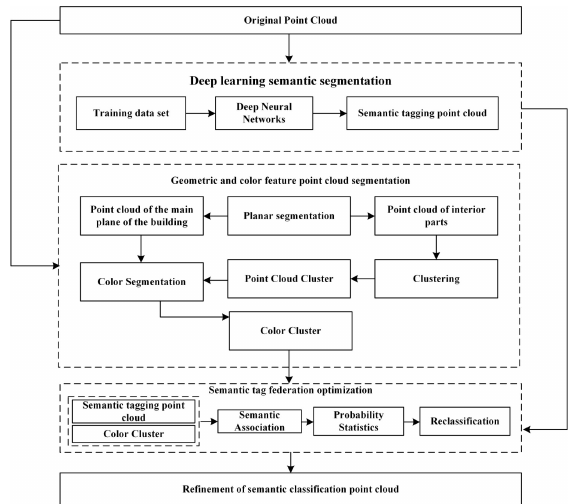
Figure 1 . Workflow of our